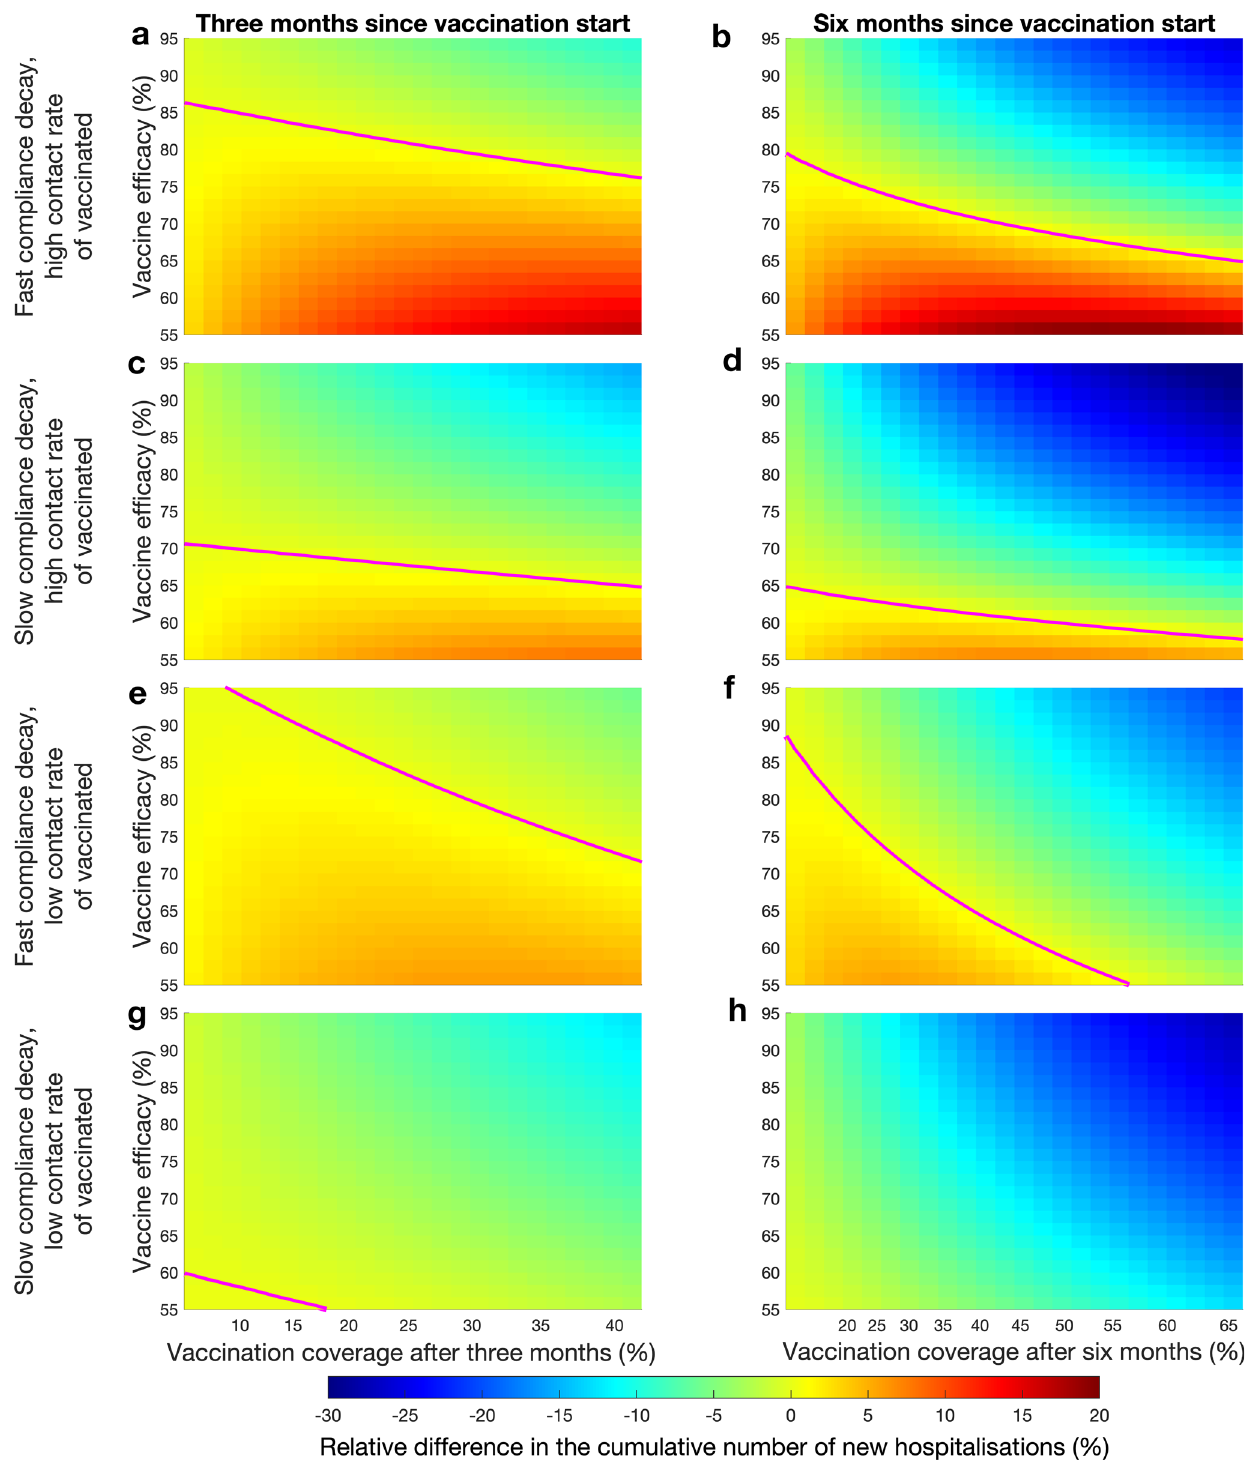
Fig. 6 Epidemic dynamics with and without interventions targeting compliance of vaccinated and non-vaccinated individuals. The original variant of the virus circulates. All panels show relative difference in the cumulative number of new hospitalisations as compared to the no-vaccination scenario. a , b Vaccination rollout not supplemented with compliance interventions three and 6 months into the vaccination rollout, respectively. c , d Vaccination rollout supplemented with compliance interventions targeting non-vaccinated individuals three and 6 months into the vaccination rollout, respectively. e , f Vaccination rollout supplemented with compliance interventions targeting vaccinated individuals three and 6 months into the vaccination rollout, respectively. g , h Vaccination rollout supplemented with compliance interventions targeting both vaccinated and non-vaccinated individuals three and 6 months into the vaccination rollout, respectively. Magenta curves mark boundaries between parameter regions with different sign of the cumulative number of new hospitalisations. The scale of x-axis is not linear since the axes were obtained by conversion of the vaccine uptake rate to the vaccination coverage following three and six months after the start of the vaccination